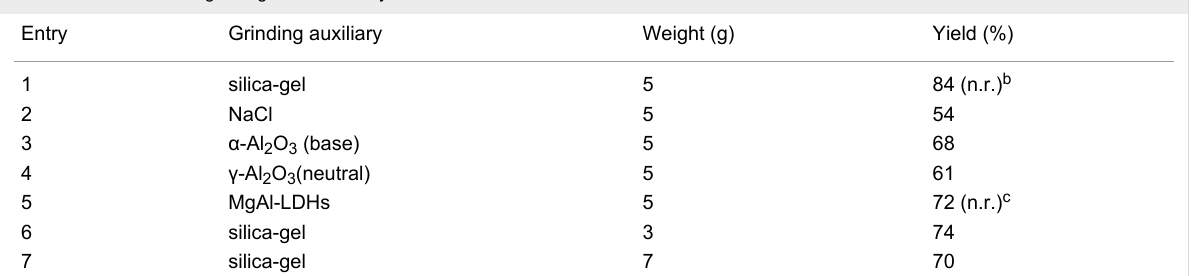
Table 2: Examination of grinding auxiliaries on yield of 3aa . a